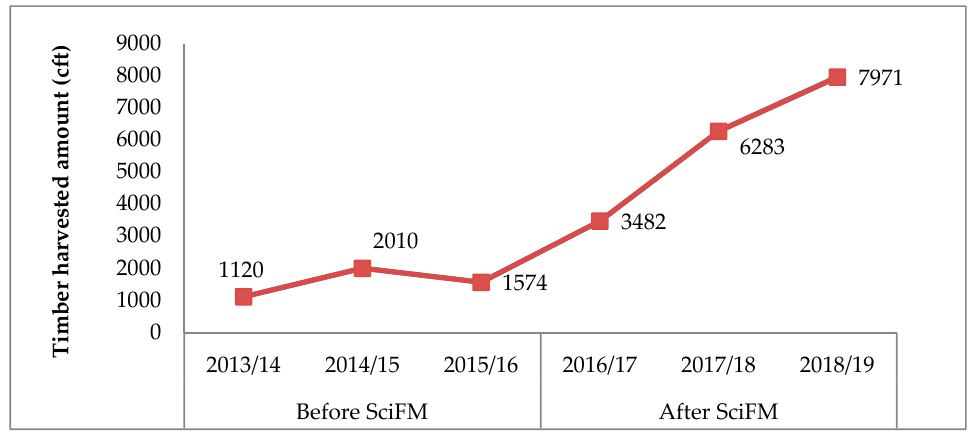
Figure 4. Timber harvesting trend before and after scientific forest management (SciFM).